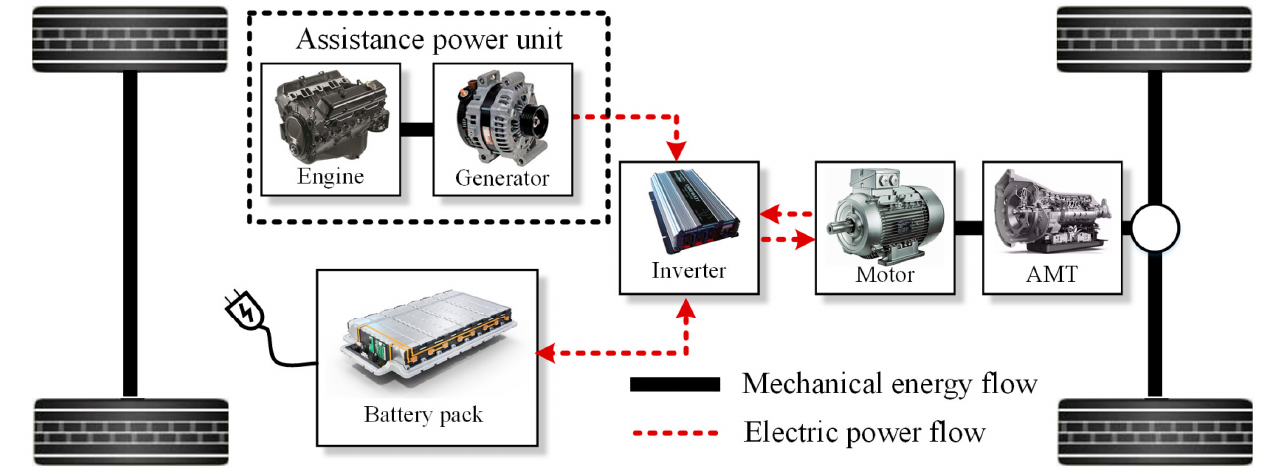
Figure 8. Structural diagram of plug-in hybrid electric vehicle [167].